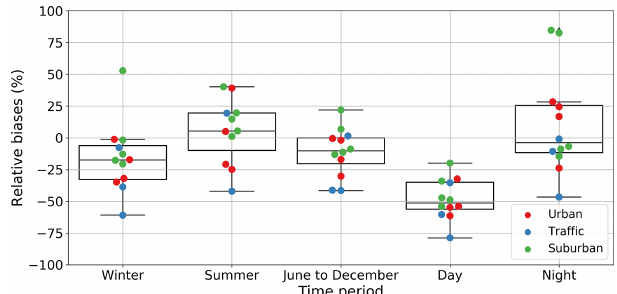
Figure 5. Box-and-whisker plot of the relative biases between the simulated and observed NO 2 concentrations for the 14 stations used for the validation during the five different periods, from left to right: winter, summer, June to December, daytime and night-time. The different colours of the markers represent distinct types of air qual- ity stations, namely urban (in red), traffic (in blue) and suburban (in green). The boxes extend from the lower to upper quartile values of the biases, while the horizontal line in each box represents the median. The whiskers extend from the box to show the range of the data and outliers past the end of the whiskers. The relative biases are calculated according to (simulations –